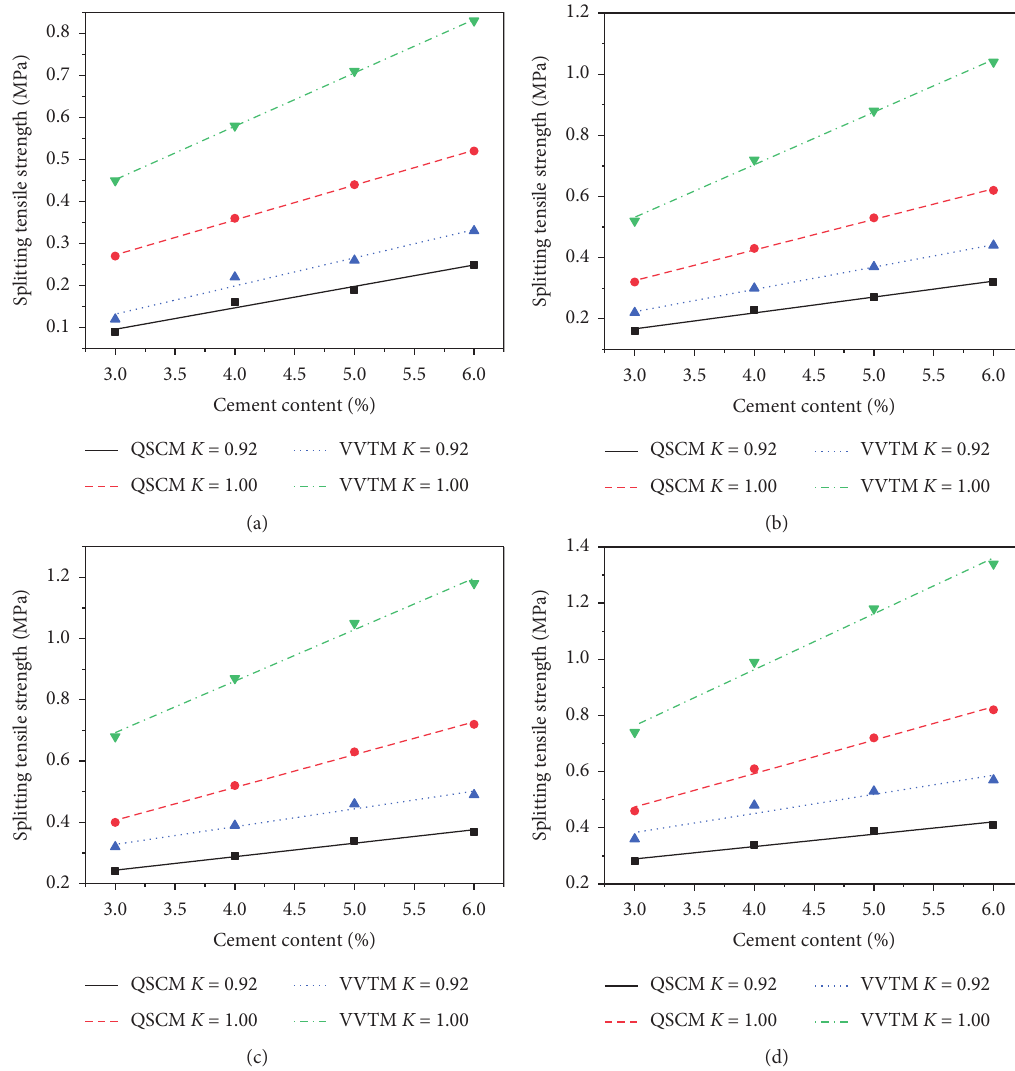
Figure 7: Influence of cement content on SPS of CSL compacted using VVCM and QSCM. (a) 7 d. (b) 14d. (c) 28d. (d)